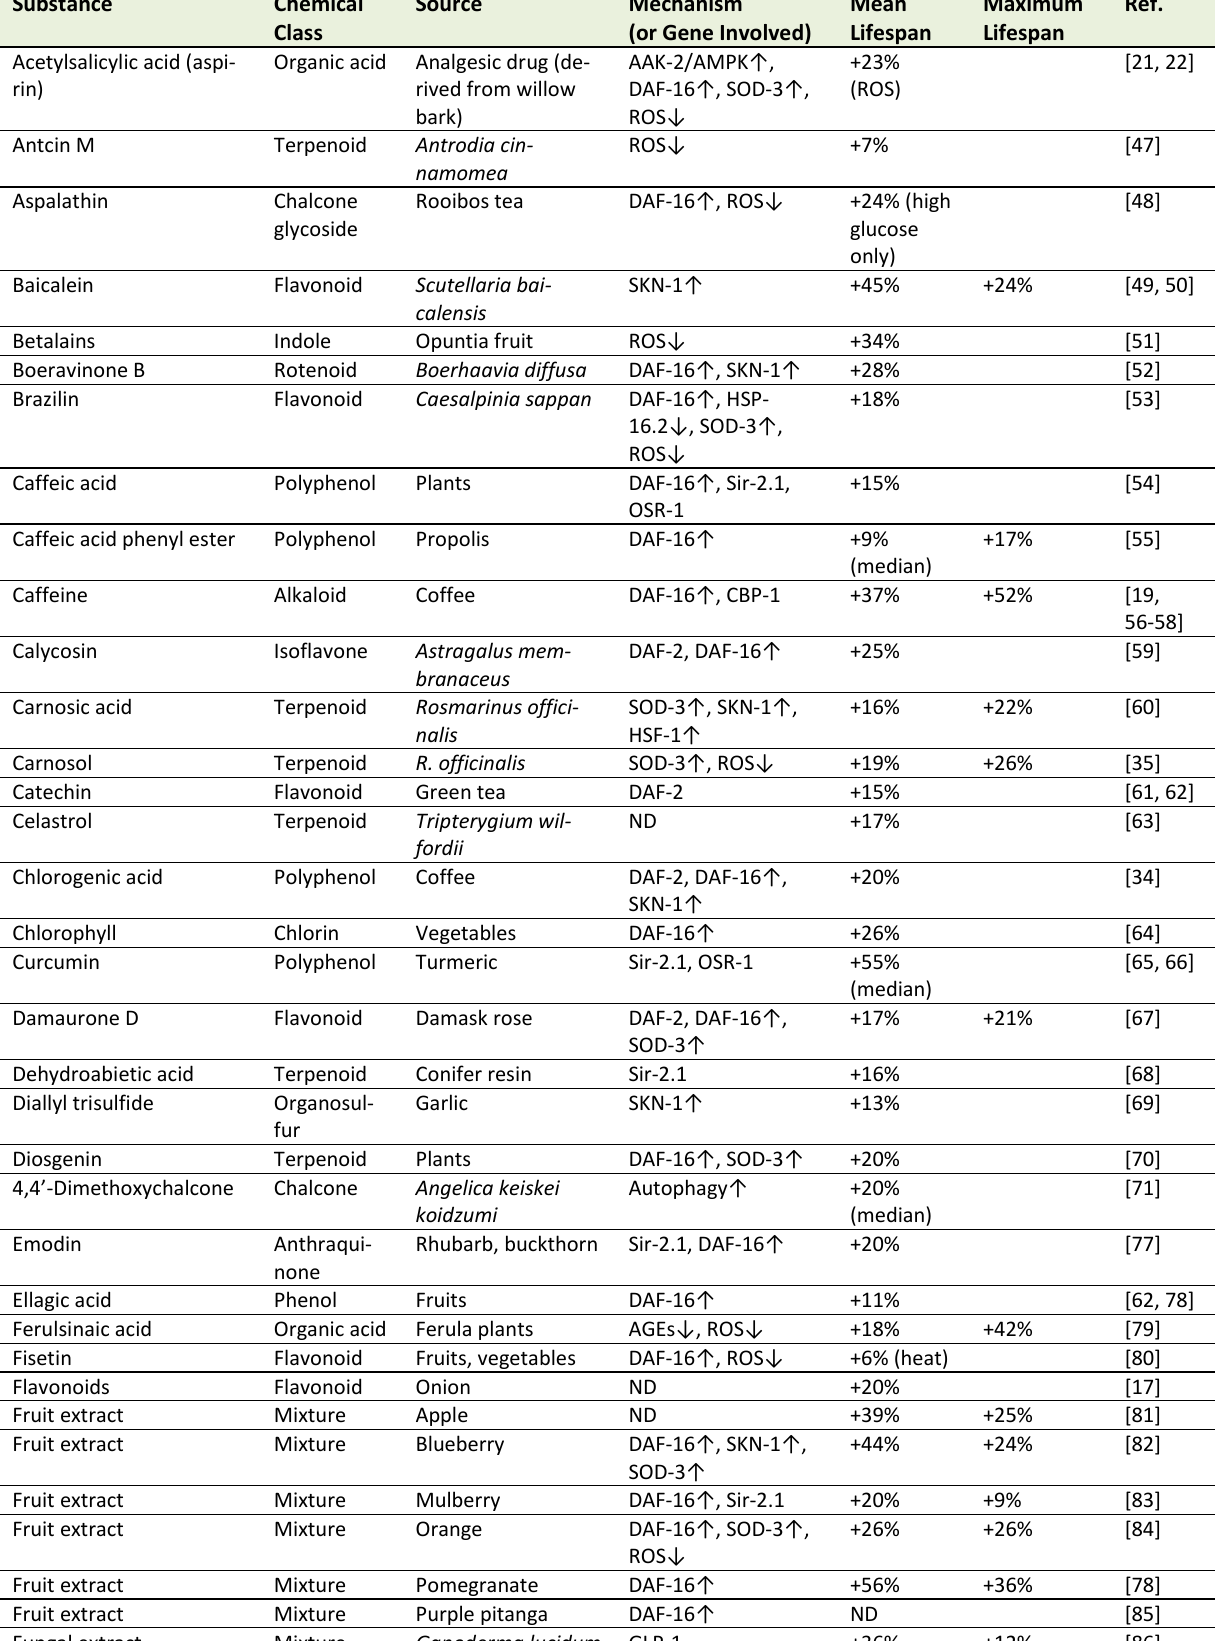
TABLE 1. Examples of naturally-occurring substances and related pharmaceutical drugs that extend C. elegans lifespan.